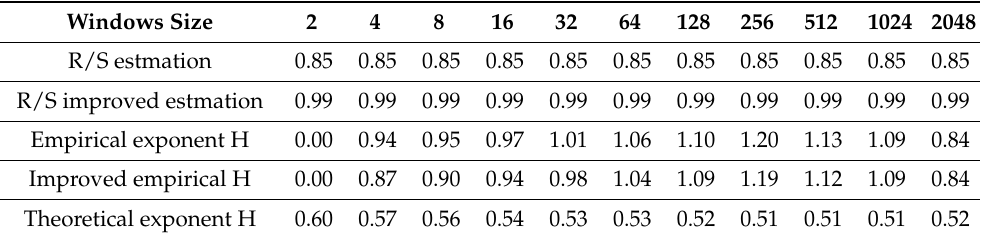
Table 2. Hurst coefficient values for specific intervals (windows